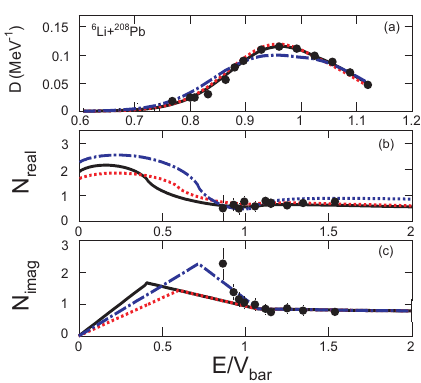
Figure 1. Determining the optical potential for 6 Li + 208 Pb via elastic scattering and backscattering measurements. (a) Barrier distributions obtained in the backscattering measurements- see Ref. [13]. (b) and (c) the real and imaginary part of the optical potential, determined in the analysis of elastic scattering data, reported in Ref. [1]. The lines represent trial potentials in a dispersive relation scheme, taking into account simultaneously the elastic scattering and backscattering measurements. Figure taken from Ref. [13].